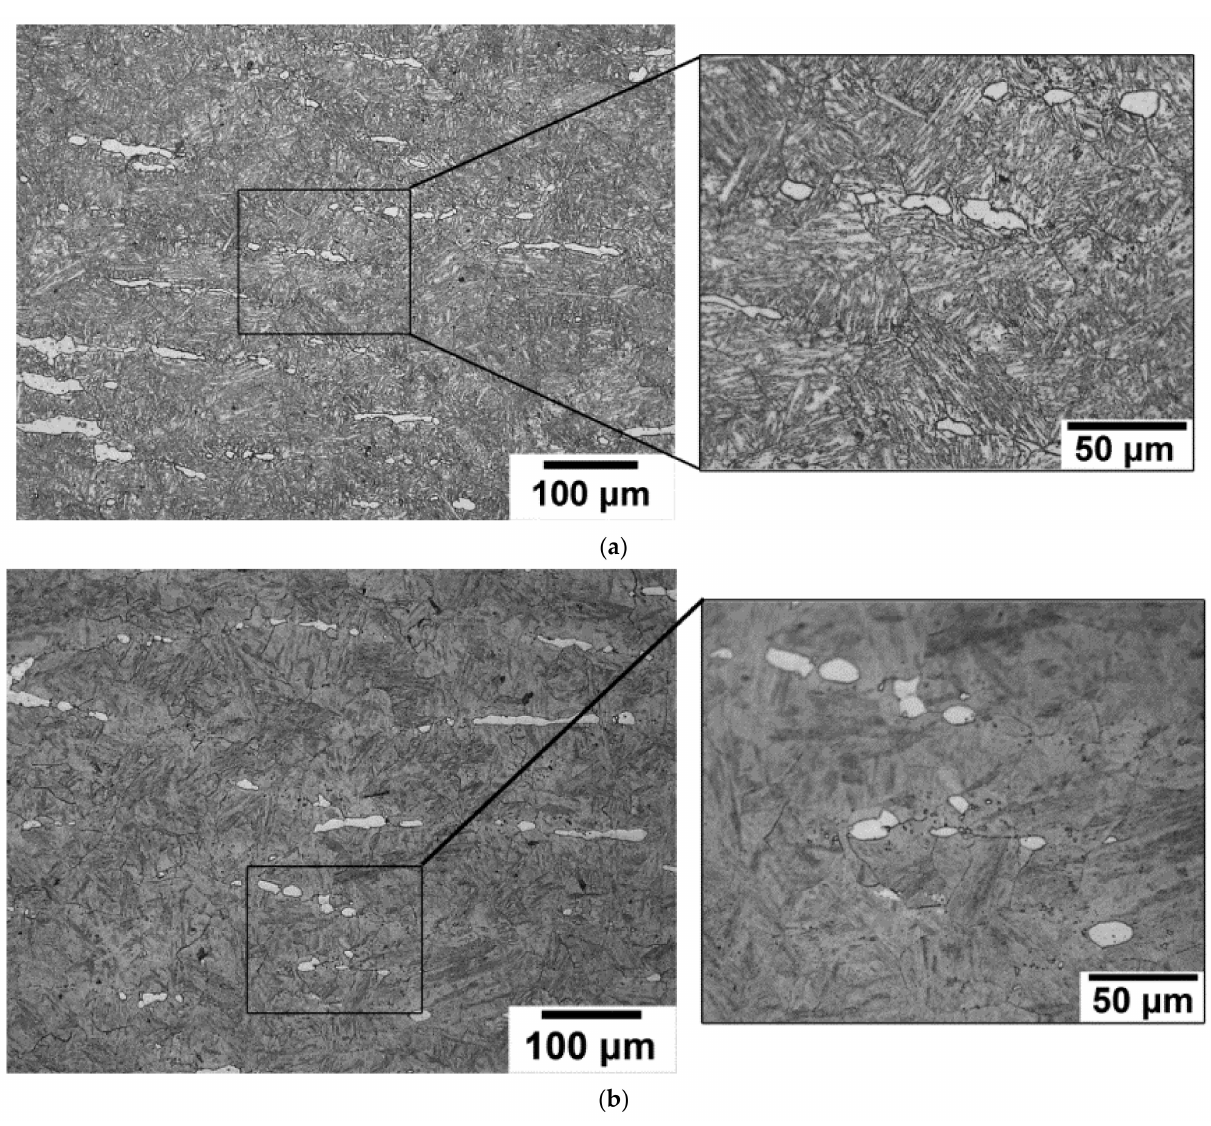
Figure 7. ( a ) Optical metallography of the 12% Cr steel structure after homogenization annealing at 1200 ◦ C for 16 h with following forging at 1200 ◦ C, air cooling, then annealing at 1050 ◦ C for 4 h with following forging at 1050 ◦ C with a true strain of ~3 and annealing at 1050 ◦ C for 4 h, air cooling, and ( b ) then normalizing at 1000 ◦ C for 24 h, air